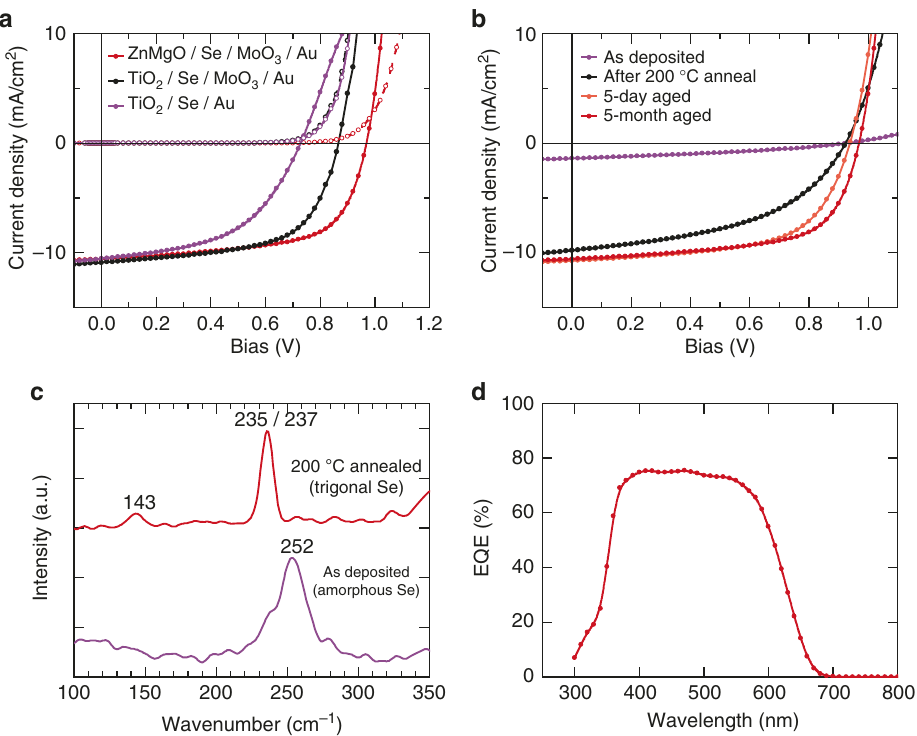
Fig. 2 a As-measured current – voltage ( J – V ) characteristics of Se solar cell devices under dark ( dashed lines ) and illuminated ( solid lines ) condition, showing the effect of buffer and hole-transport layer. ZnMgO/Se/MoO x /Au, TiO 2 /Se/MoO x /Au, and TiO 2 /Se/Au devices are shown in red , black , and purple , respectively. b Illuminated J – V plots of ZnMgO/Se/MoO x /Au devices with as-deposited Se, annealed at 200 ˚ C, 5-day aged after annealing, and 5-month aged after annealing Se are shown in purple , black , orange and red . c Raman spectra of as-deposited Se ( purple ) and annealed Se at 200 °C ( red ). The annealed Se shows convoluted peaks at 235 and 237 cm − 1 . d External quantum ef fi ciency spectrum of a ZnMgO/Se/MoO x /Au